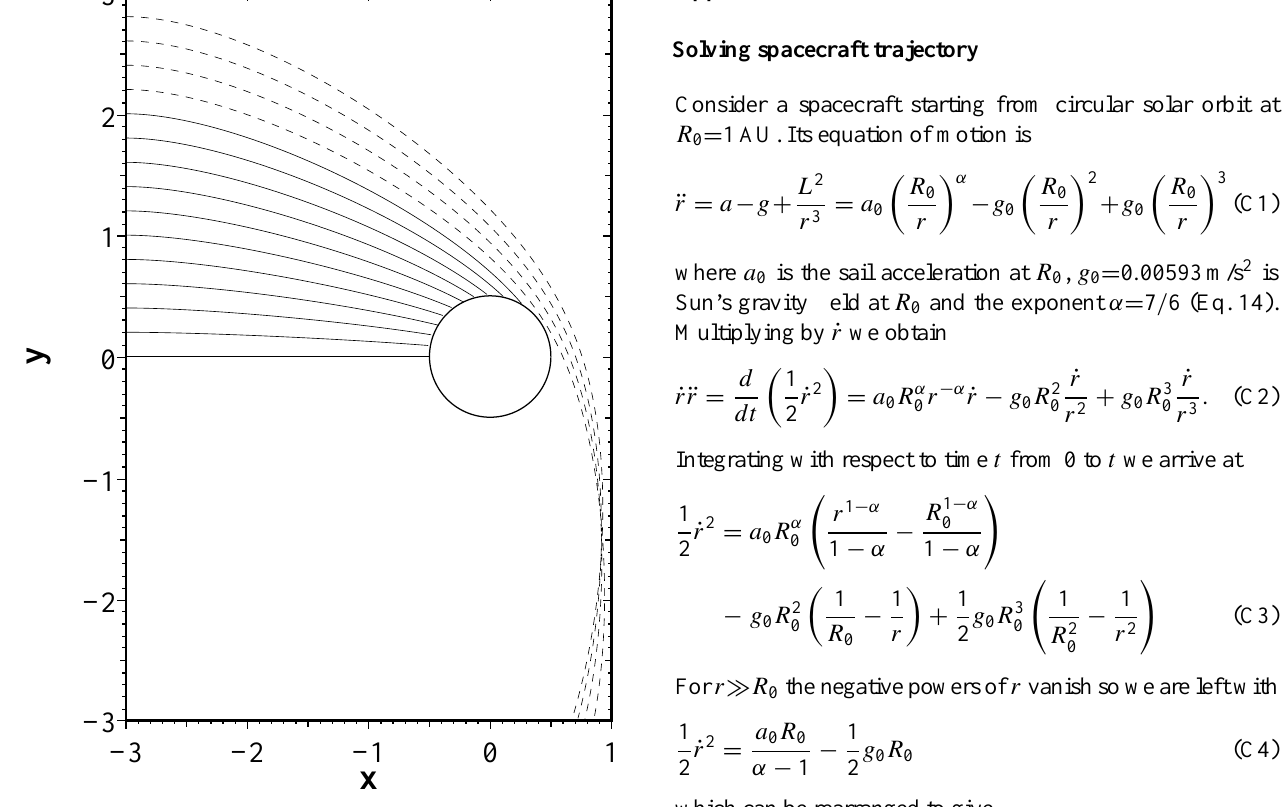
Fig. B1. Geometry of Appendix B. Electrons arrive from the left. Those with small enough impact parameter (initial y-coordinate) hit the wire (solid lines) while others pass by it (dashed lines). The scales are